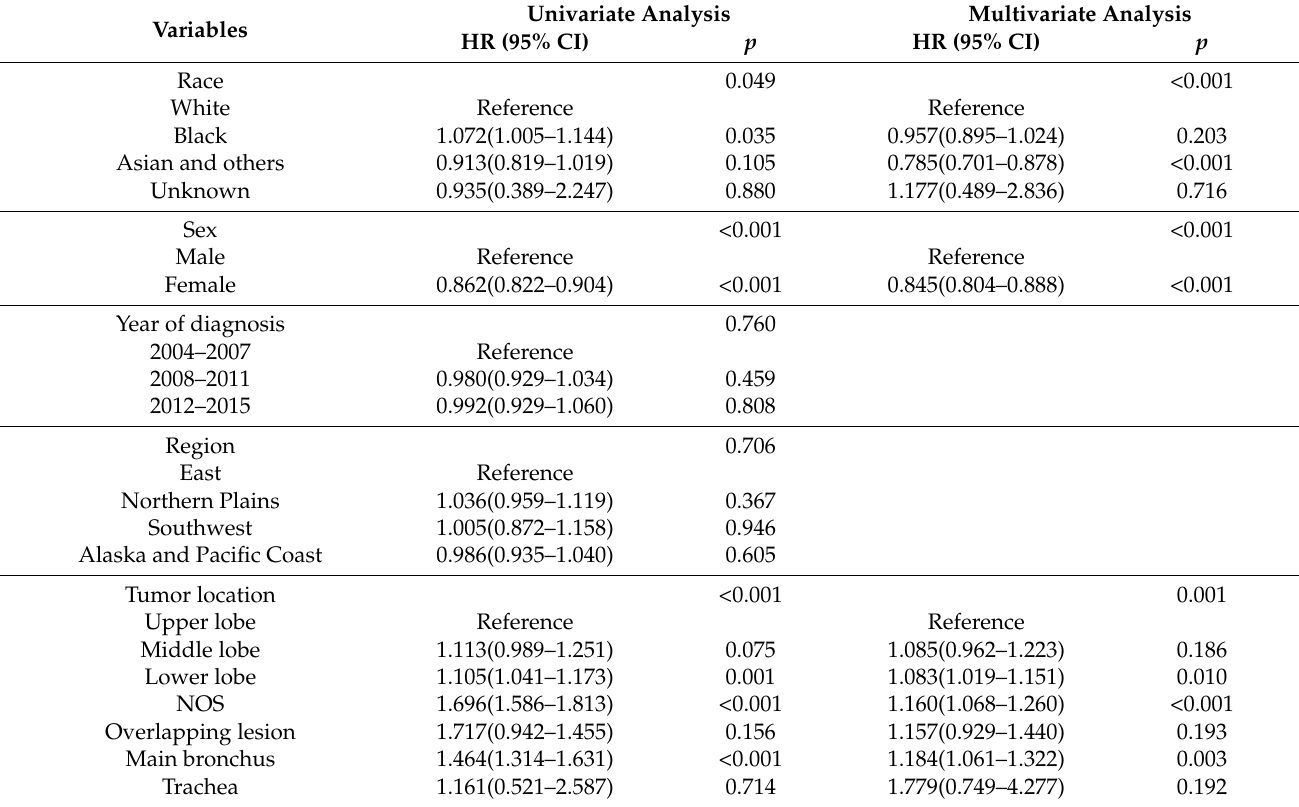
Table 3. Univariate and multivariate COX regression analysis on OS in LCC